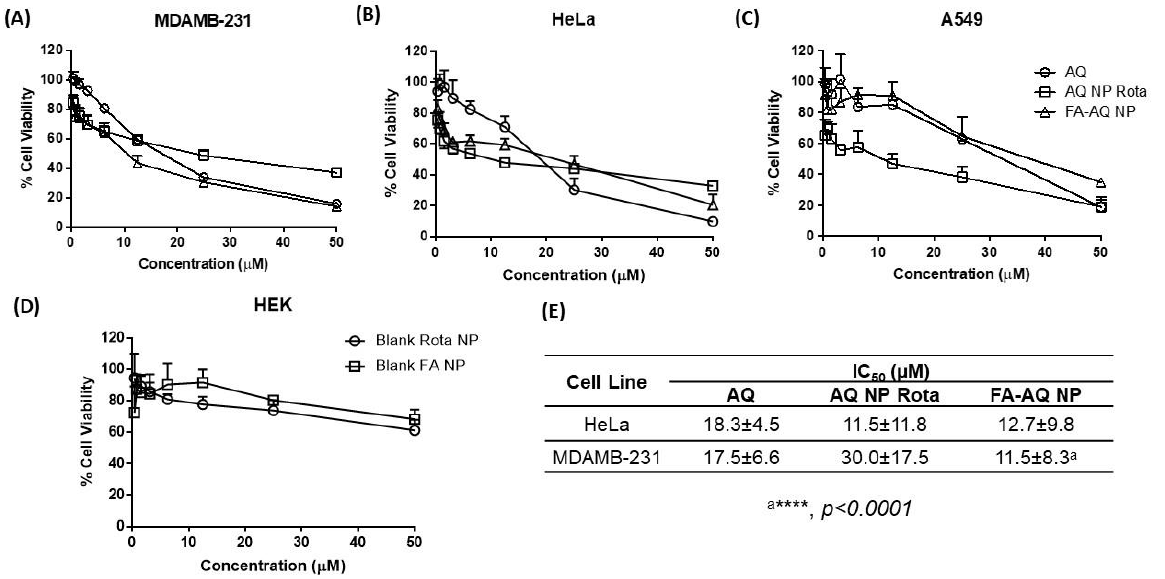
Figure 6. Inhibitory effects on different cell lines ( A ) MDAMB-231, ( B ) HeLa, ( C ) A549 after treatments with AQ, AQ NP Rota, and FA-AQ NP. ( D ) Cell viability in HEK-293 cell line after treatment with blank non-targeted and FA-targeted NPs; and ( E ). IC 50 of AQ, AQ NP Rota, and FA-AQ NP in HeLa and MDAMB-231. Data represent mean ± SD (n = 6) of at least 3 independent trials. ( A – C ). Data represent mean ± SD (n = 6) ( D ). **** p < 0.0001. The IC 50 values for AQ, AQ NP Rota, and FA-AQ NPs were found to be 18.3 ± 4.5 µM, 11.5 ± 11.8 µM, and 12.7 ± 9.8 µM in the HeLa cell line (Figure 6B); and 17.5 ± 6.6 µM, 30.0 ± 17.5 µM, and 11.5 ± 8.3 µM in the MDAMB-231 cell line, respectively (Figure 6A).